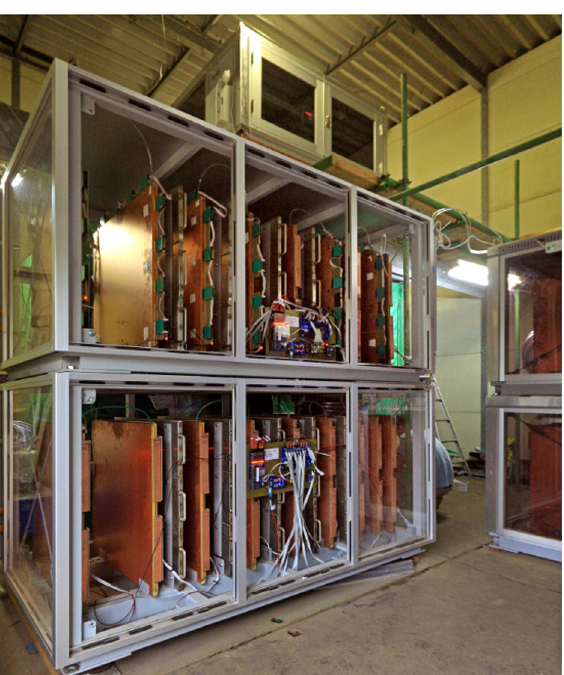
Figure 2. Photograph about three tracking systems of Multi-Wire-Proportional-Chamber-based Muography Observation System (MMOS). Ten MMOS operated in the Sakurajima Muography Observatory during the data collection